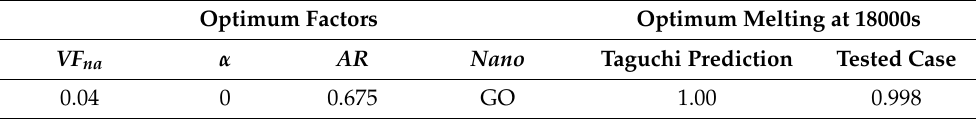
Figure 4. The S/N ratios for all the levels of the design variables: Optimum levels: A = 5, B = 3; C = 2 and D = 2. Table 7. The optimum